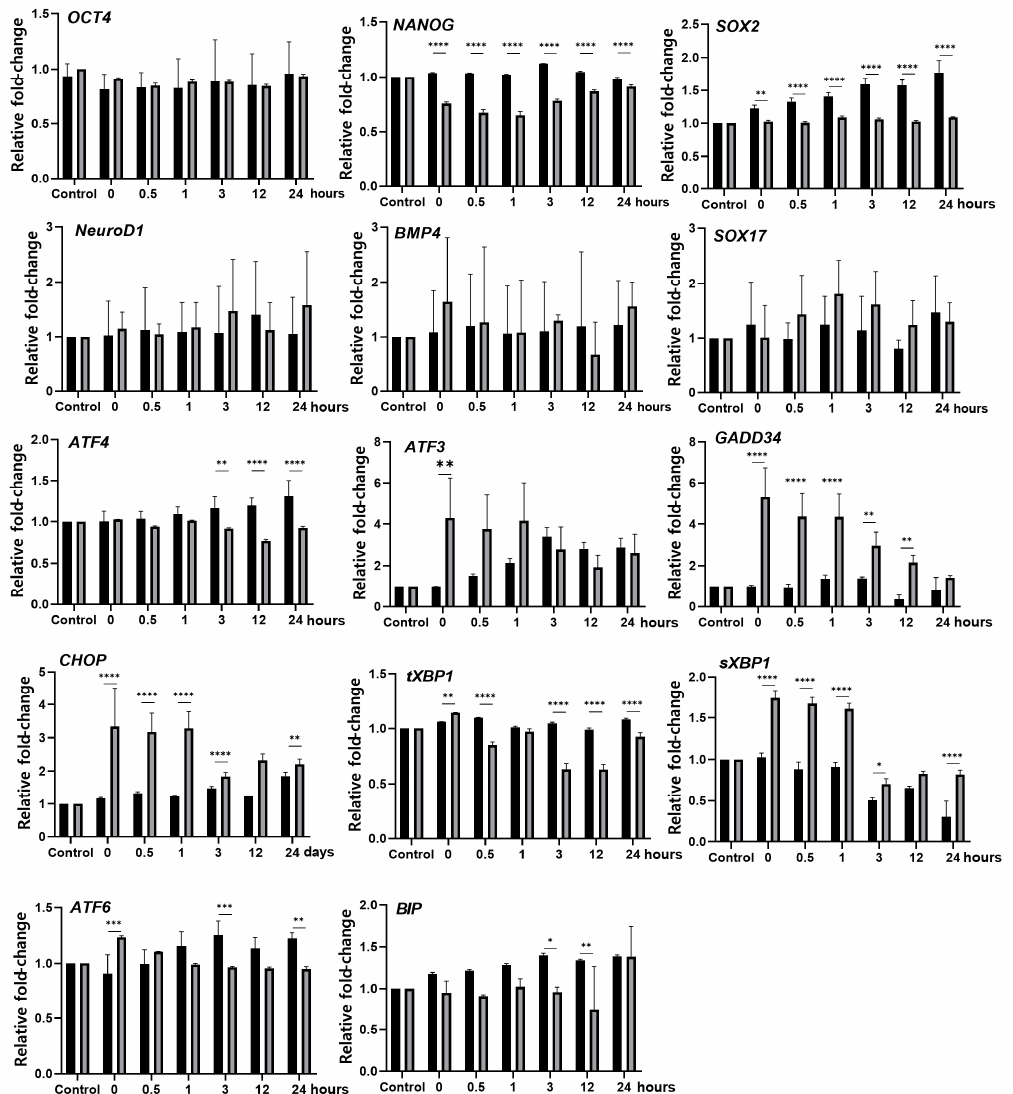
Figure 2. Hyperthermia activates the embryoid body (EB) stress pathway in human EBs. RT-qPCR analysis of the EBs cultured under normothermic (black bars) and hyperthermic (gray bars) conditions. Gene expression of the markers of stemness ( OCT4, NANOG , and SOX2 ), lineage-specific markers ( NeuroD1 , BMP4 , and SOX17 ), and ER stress-induced UPR-related genes ( ATF4, ATF3, GADD34, CHOP, tXBP1, sXBP1, ATF6 , and BIP ). The housekeeping gene GAPDH was used as a loading control. Fold changes of signal intensity were normalized by GAPDH intensities. Fold changes shown are the mean values obtained from three independent experiments. Statistical significance was determined by comparing the relative band intensities and referring to those of undi ff erentiated hESCs as 1. Student’s t -test: * p < 0.05, ** p < 0.01, and *** p < 0.001, **** p <